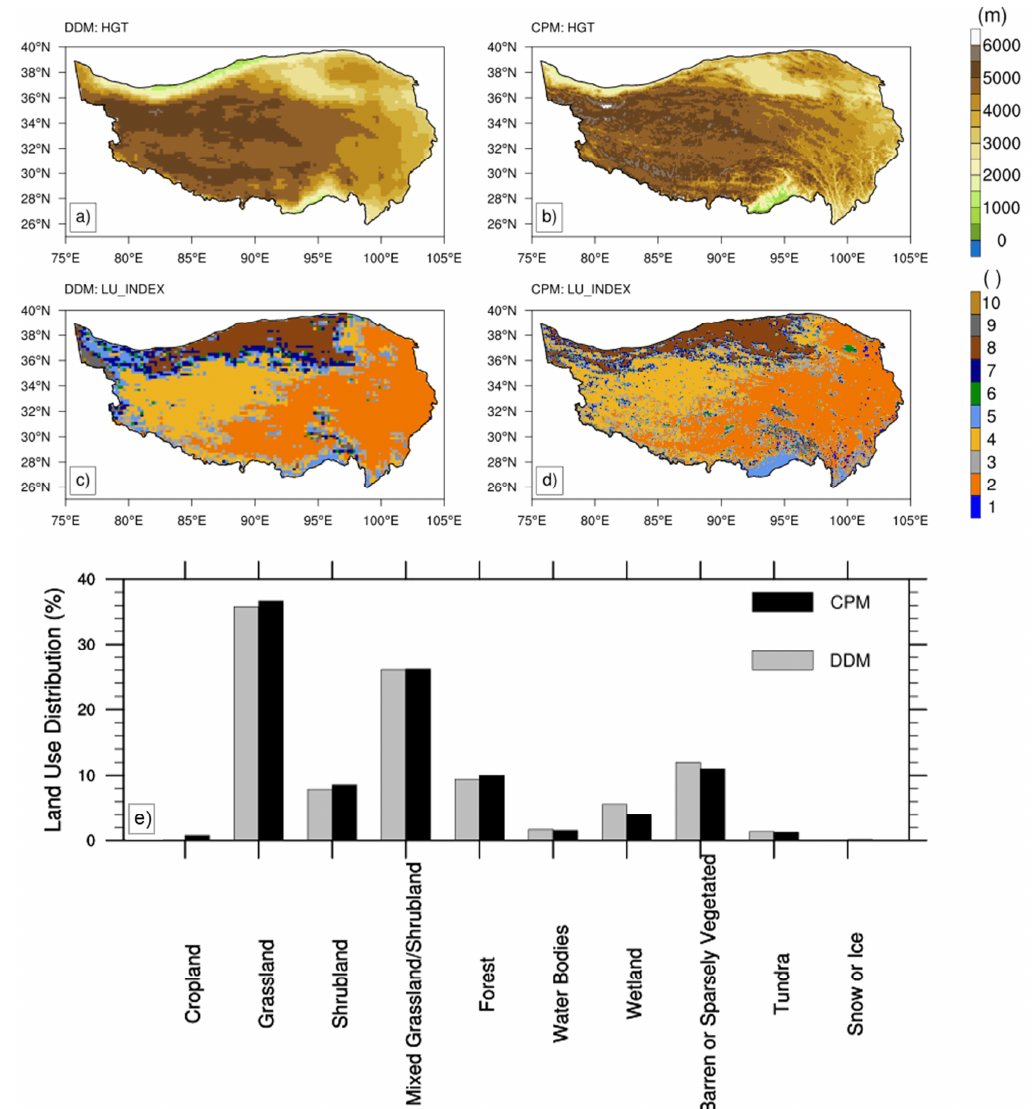
Figure 1. ( a , b ) The distribution of topography (unit: m), and ( c , d ) the dominant land-use categories over the Tibetan Plateau (TP). Panels ( a , c ) are from DDM (dynamical downscaling modeling), and panels ( b , d ) are from CPM (convection-permitting modeling). ( e ) The land-use distribution (unit: %) of ten dominant categories. In ( c – e ), the numbers 1–10 stand for cropland, grassland, shrubland, mixed grassland/shrubland, forest, water bodies, wetland, barren or sparsely vegetated, tundra, snow or ice, respectively.